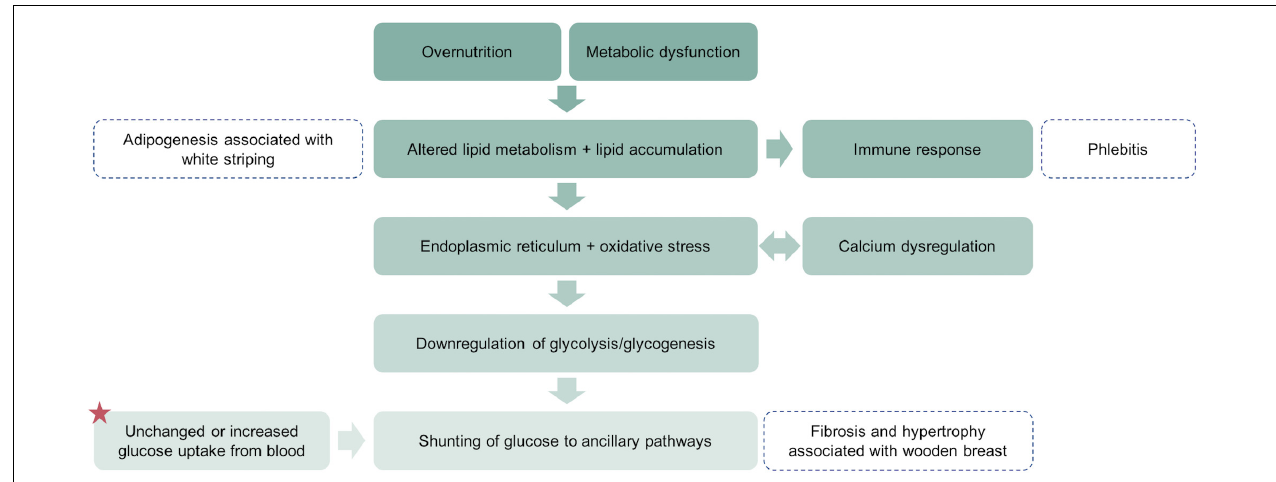
FIGURE 1 | A simplified schematic representation of the proposed pathogenesis of wooden breast and white striping in the pectoralis major muscle. A key difference between wooden breast in broilers and type 2 diabetes in mammals is the dependence on insulin-independent glucose transport in skeletal muscle of chickens. This results in unchanged or increased uptake of glucose from blood (star) even when glycolysis and glycogenesis are substantially downregulated and shunting of that glucose into alternative pathways that contribute to the wooden breast